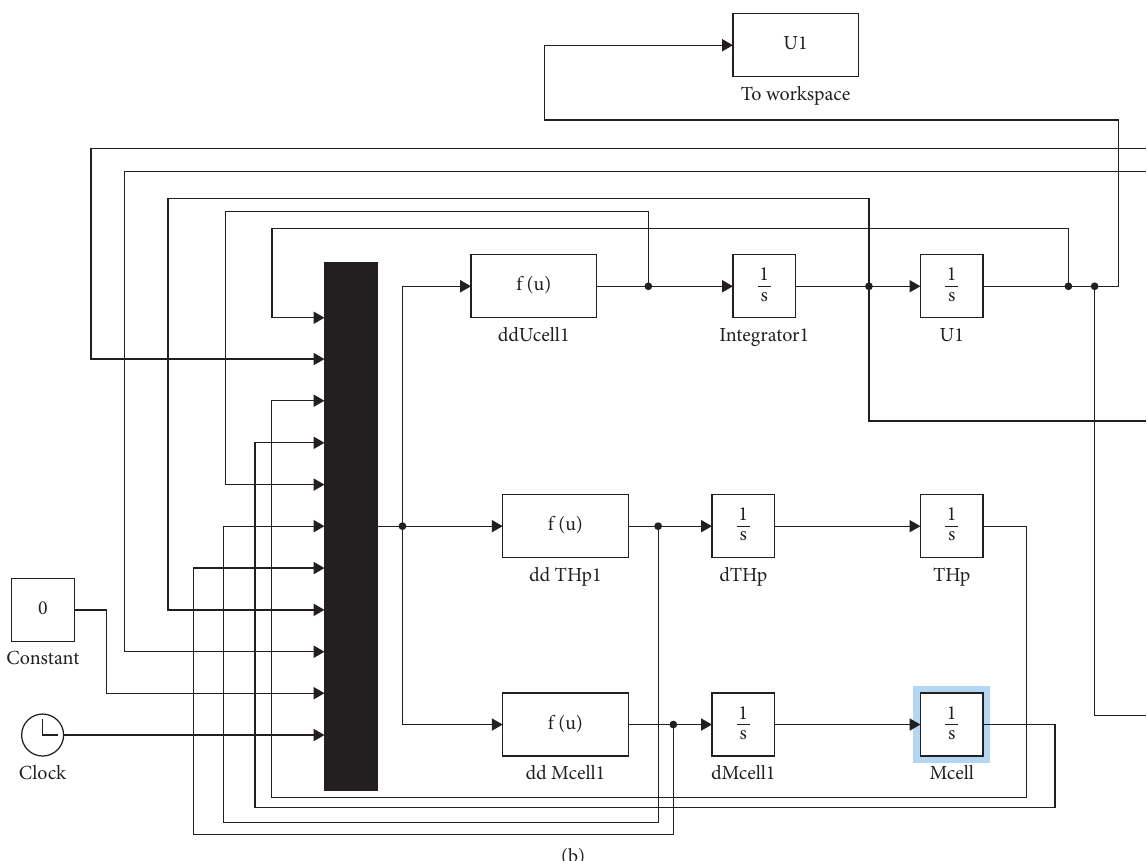
Figure 10: Block diagrams plotted in MATLAB/Simulink for the numerical solution of governing equations. (a) 1DOF model. (b) 2DOF model, array of cells (top) and a unit cell (bottom).